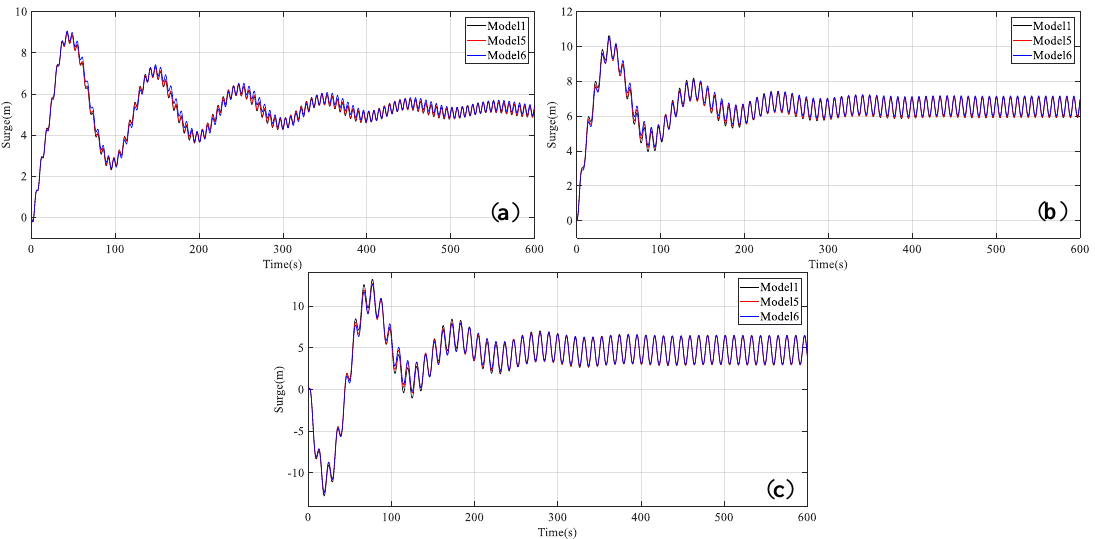
Figure 14. Time domain curves of the surge motion of the inclined upper column models: ( a ) LC1; ( b )